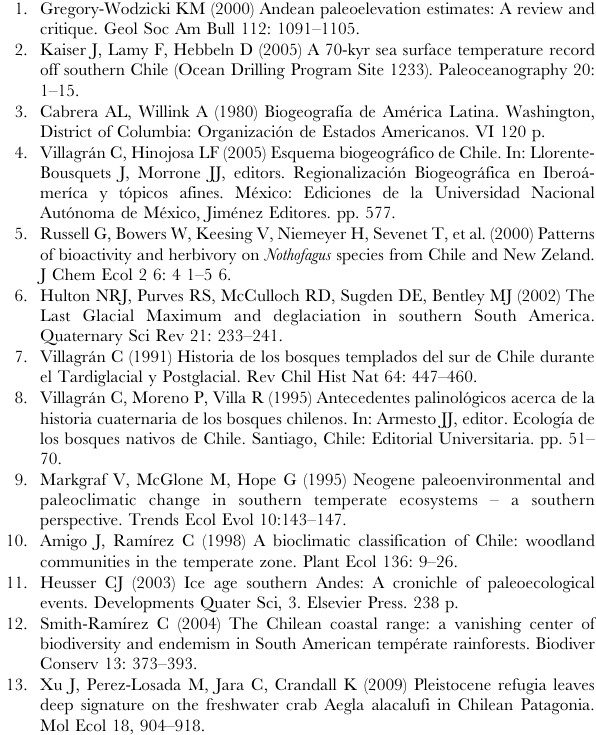
Table S4 Estimates of evolutionary divergence (p- distance bellow the diagonal), over sequence pairs between phylogroups (clades) in Liolaemus pictus . Greyscale according to evolutionary divergence values. Values on the diagonal are intra clades p-distances. Standard error estimates are shown above the diagonal. Phylogroups codes as in Fig. 2. (DOC) Figure S1 Haplotype networks for the nuclear gene EXPH5 in L. pictus . Grey haplotypes correspond to the outgroups L. lemniscatus (L.l), and L. tenuis (L. t). Color codes as in the map of Fig. 1.